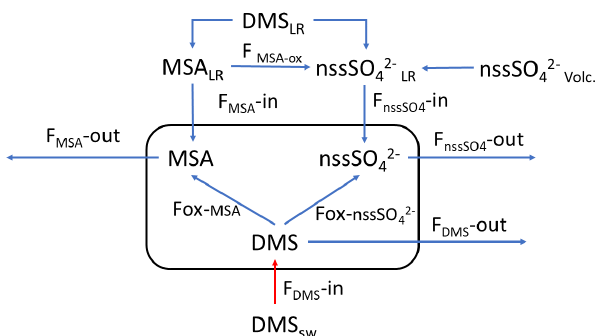
Figure 5. Schematic representation of the processes related to the measured concentration of DMS, MSA and nssSO 2 − text for the abbreviations’